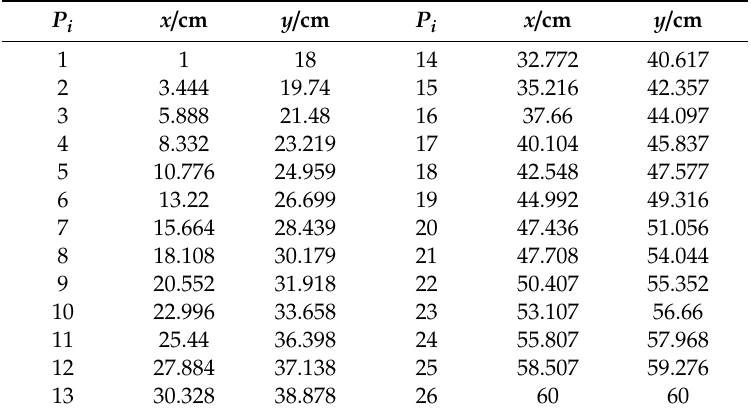
Table 2. Path points of the end-effector obtained by the improved artificial potential field method.